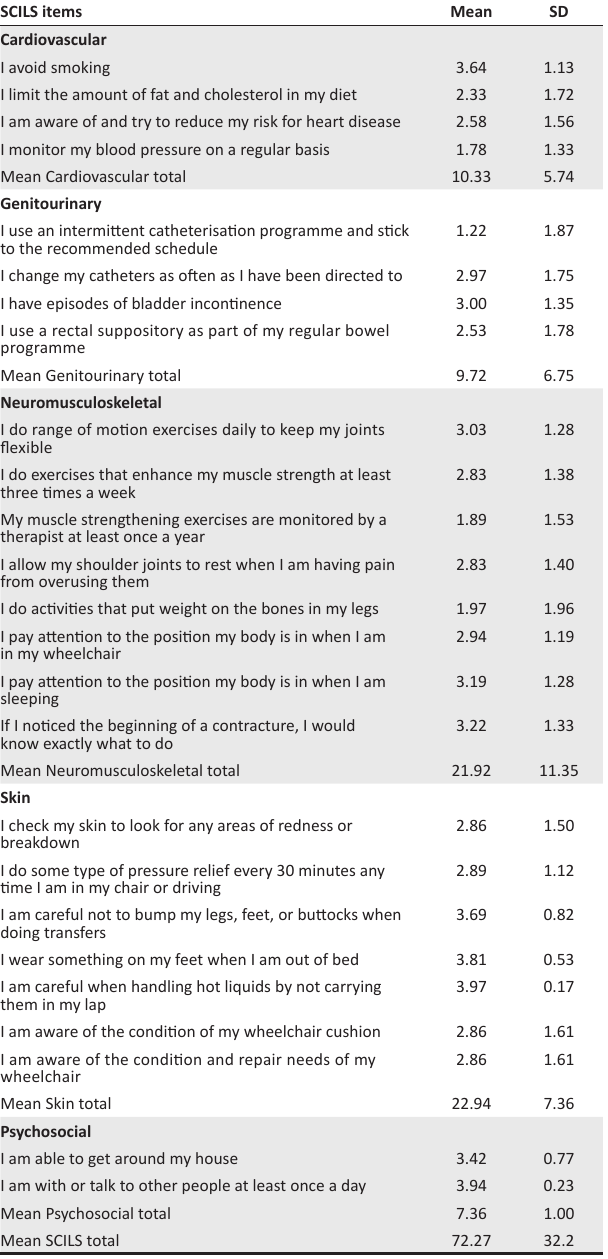
FIGURE 1: Achieved versus expected Spinal Cord Independence Measure Scale III scores of people with spinal cord injury. TABLE 2: Descriptive statistics of the Spinal Cord Injury Lifestyle Scale ( n =